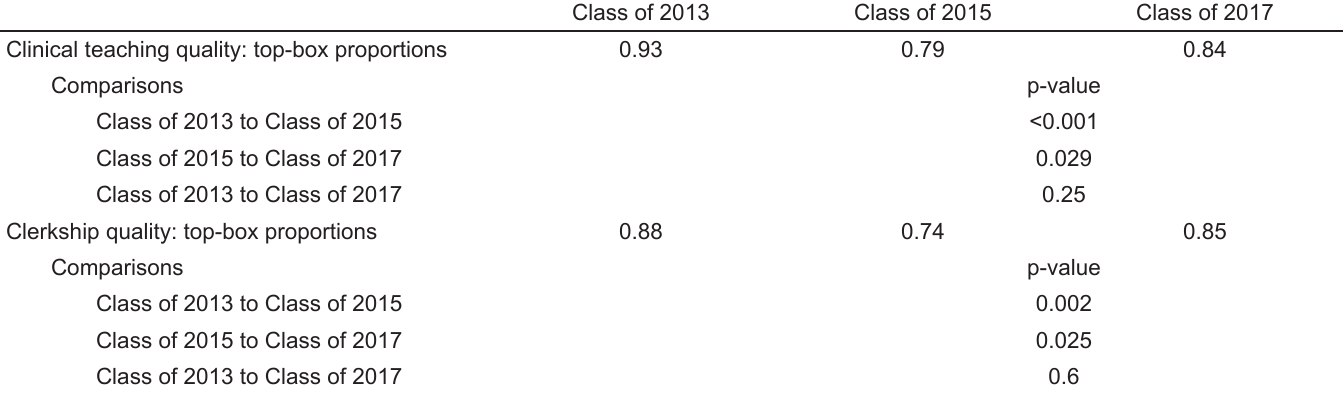
Table 2. Top-box proportions and comparisons for clinical teaching quality and overall clerkship quality for the graduating classes of 2013, 2015, and